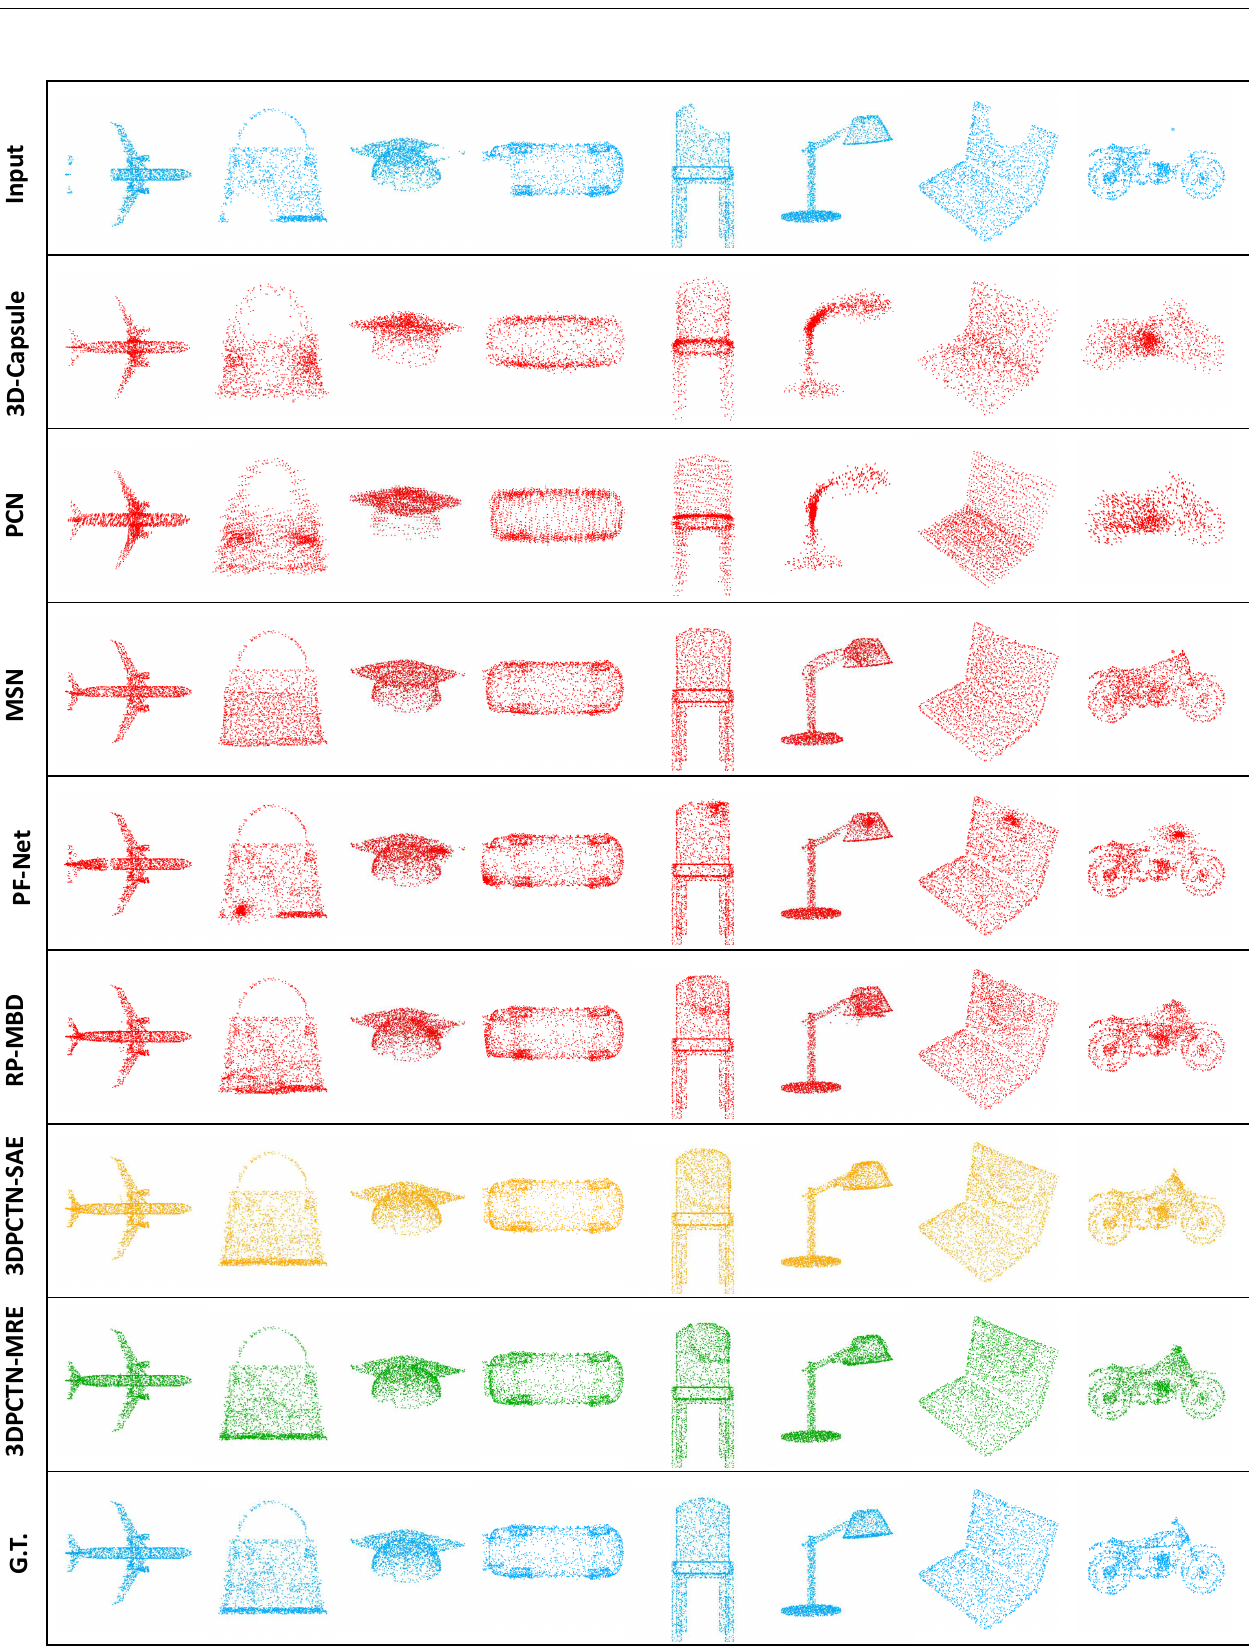
Figure 8. Comparison of completion results between our method and state-of-the-art methods. Our 3DPCTN (3DPCTN-SAE and 3DPCTN-MRE) successfully predicts the missing part and integrates it to produce a good